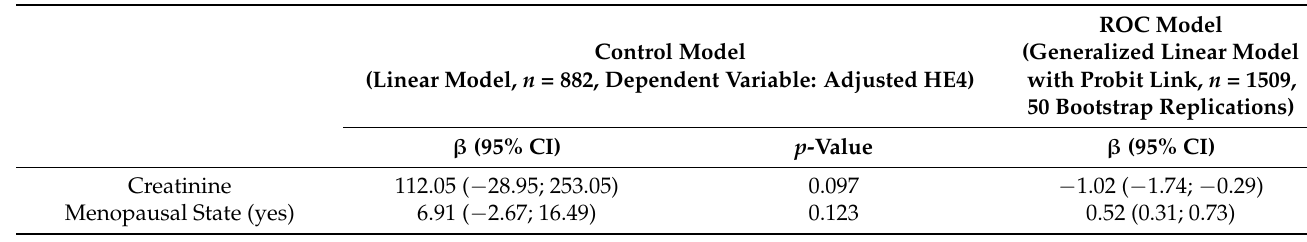
Table 3. Parametric analysis of the ROC curve regression model with bootstrap sampling.